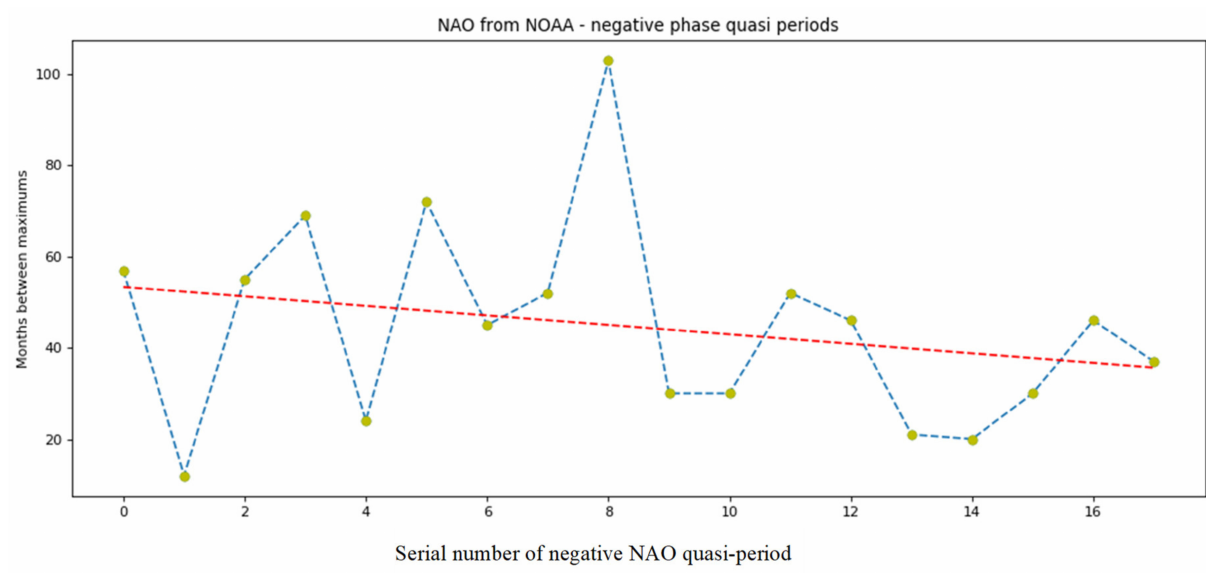
Figure 15. Illustration of quasi-periodicity (time between consecutive minima of NAO episodes), based on Table S4. Numbers of episodes follow from this table.